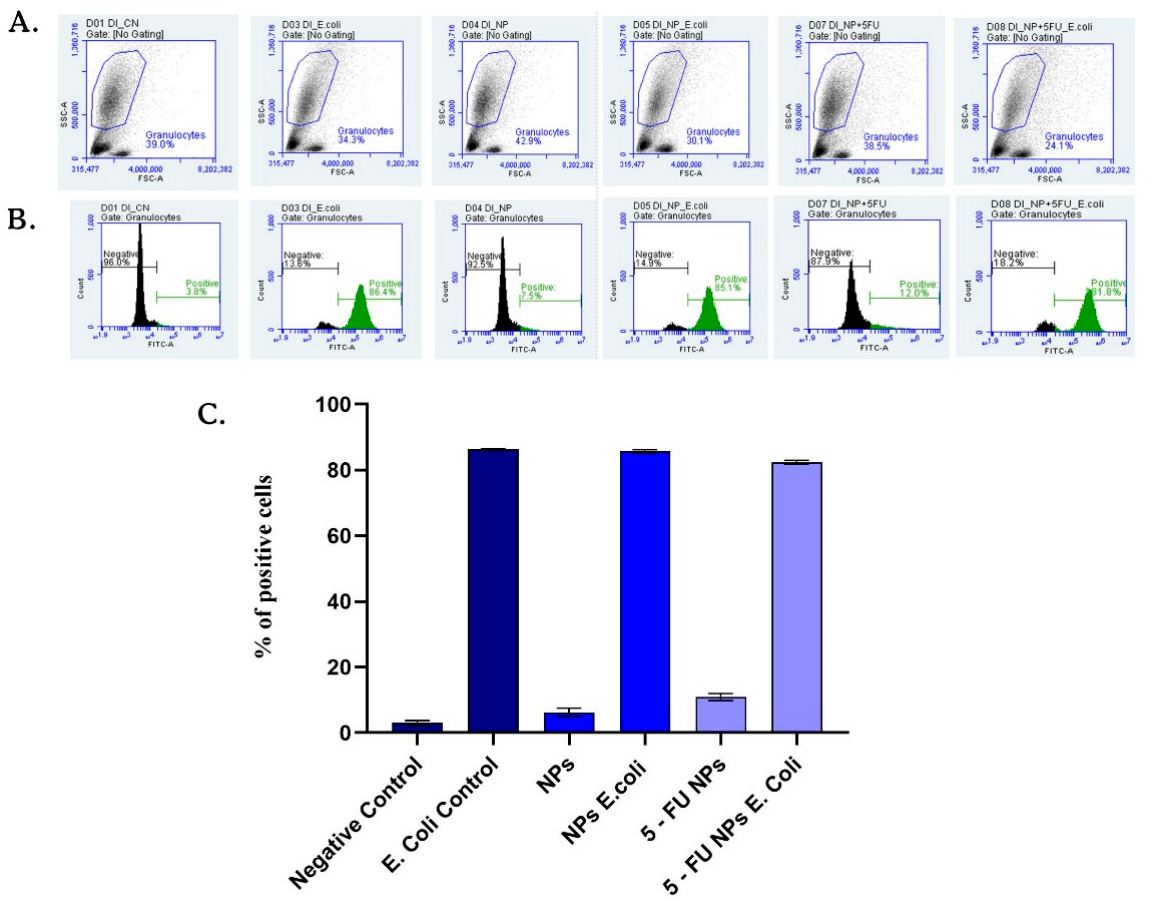
Figure 9. SF/PEG NPs ± 5-FU NPs effect on phagocytic activity of granulocytes. Dot plots ( A ), histograms ( B ), and graphic representation of the mean values of rhodamine-positive granulocytes percentages ( C ) obtained in the presence of tested NPs compared to negative or E. coli stimulated controls.